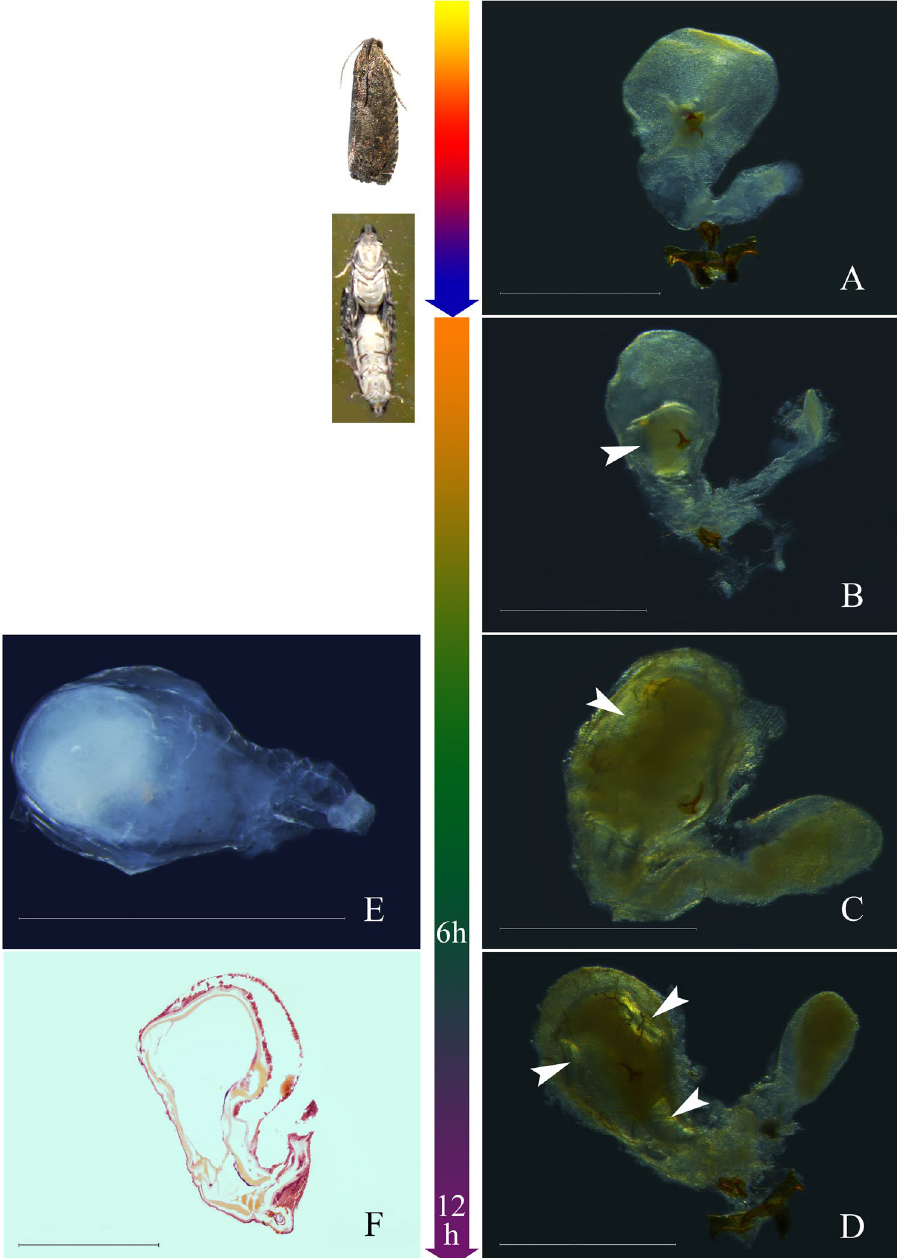
Figure 8. Morphology of corpus bursa before and after mating (h: hours after mating). Scales = 1.0 mm. ( A ) Virgin females; ( B ) Immediately after effective mating (arrow show spermatophore); ( C ) 6 hours after mating (arrow show bubble); ( D ) 12 hours after mating (arrows show bubbles); ( E ) Spermatophore; ( F ) Semithin section of 12 hours after